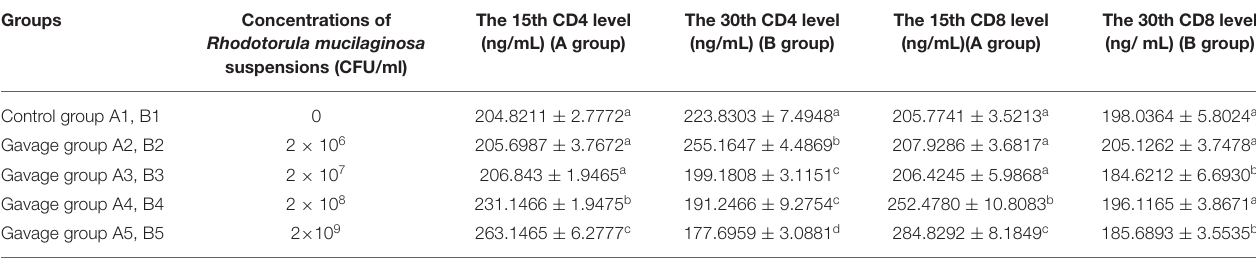
TABLE 6 | Effects of R. mucilaginosa on CD4 and CD8 content in mouse serum. Groups